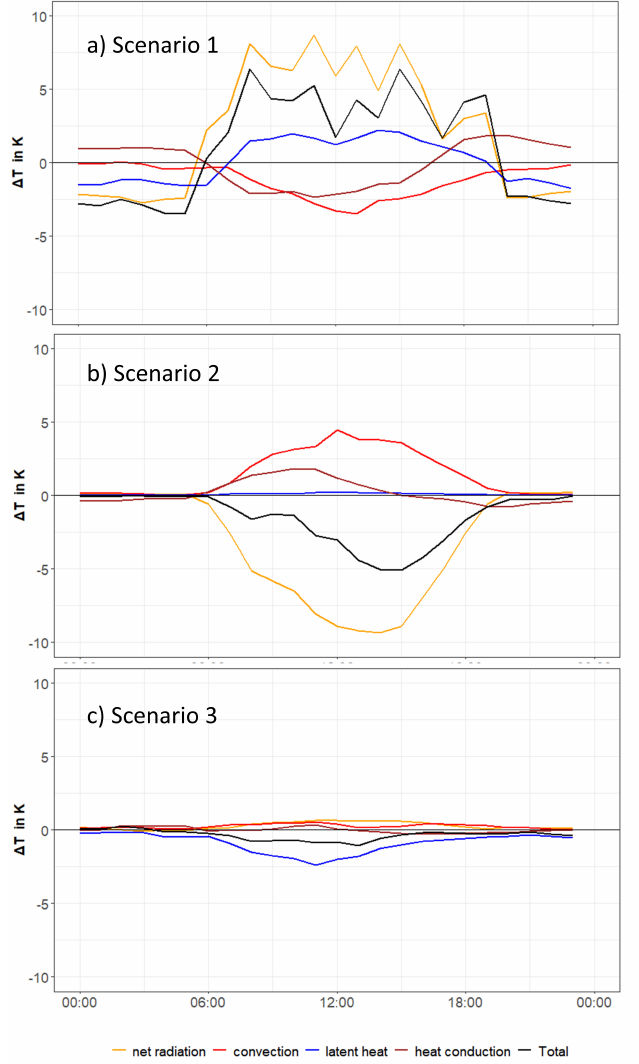
Figure 8. Diurnal variation of the total differences of the spatial mean values of T SFC in terms of the biophysical processes for the absence of vegetation ( a —Scenario 1), an increase in surface albedo ( b —Scenario 2), and surface irrigation ( c —Scenario 3) compared to the current